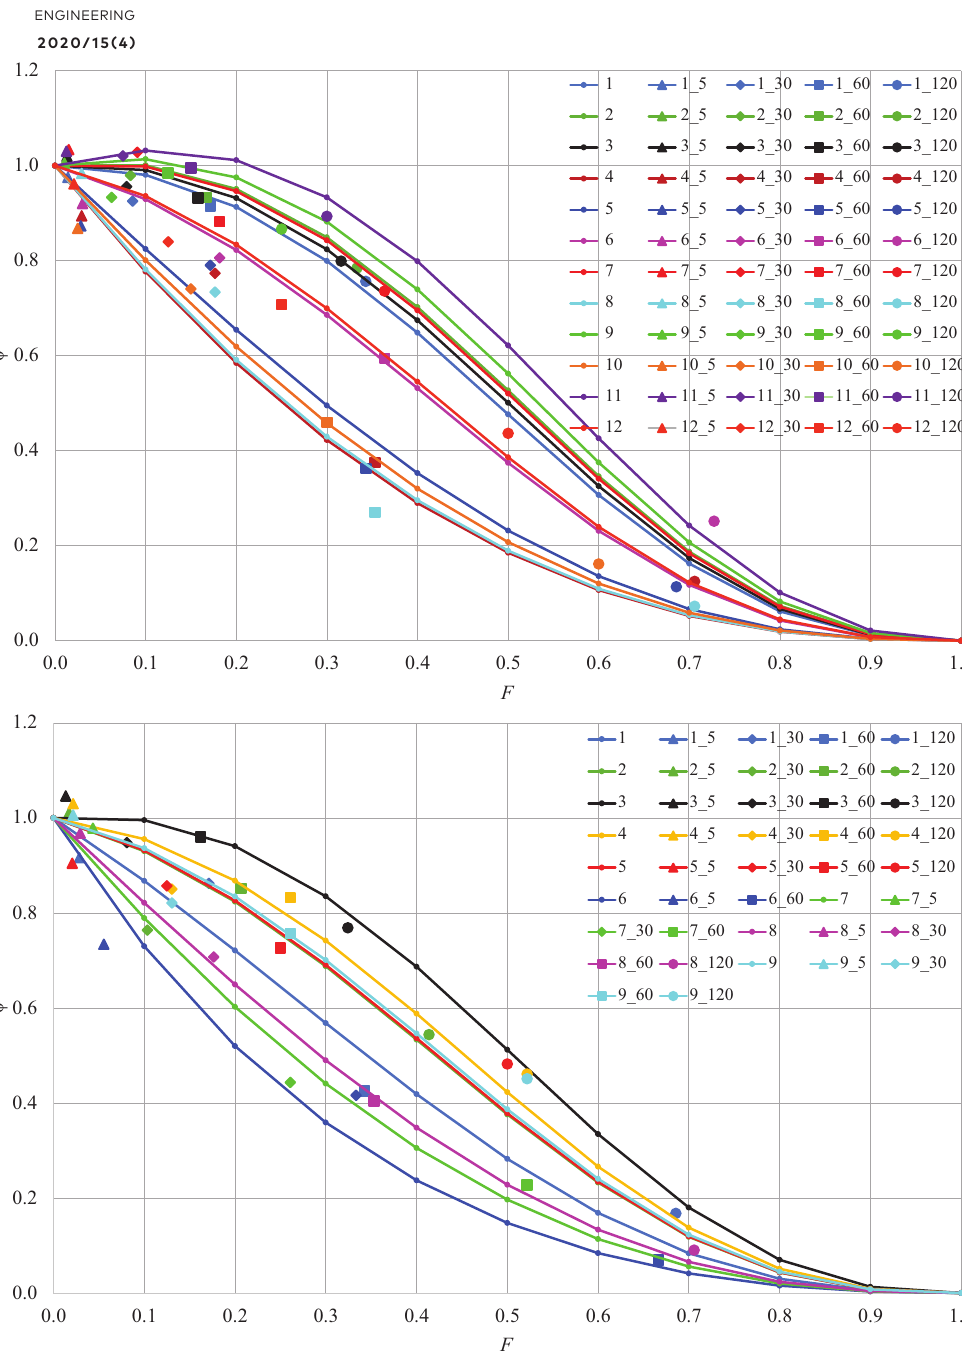
Figure 3. Experimental data and model curves: a) SMA; b)